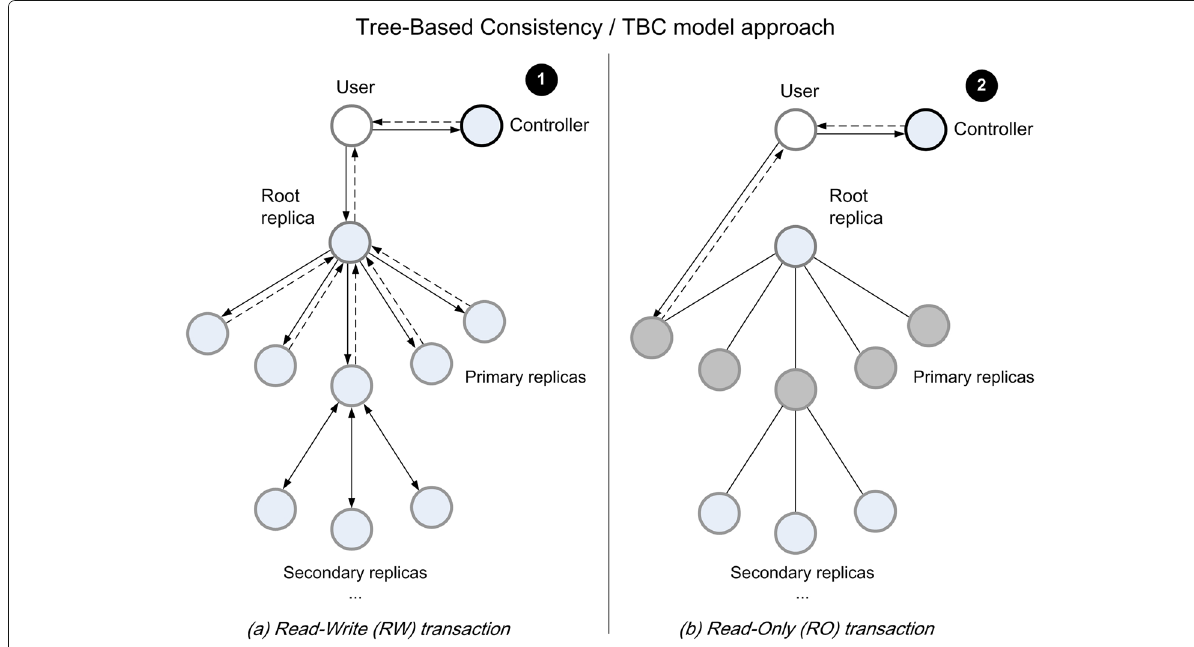
Fig. 3 Standard approach for consistency management of a highly-distributed environment - an example of the execution of read and write operations within the TBC approach